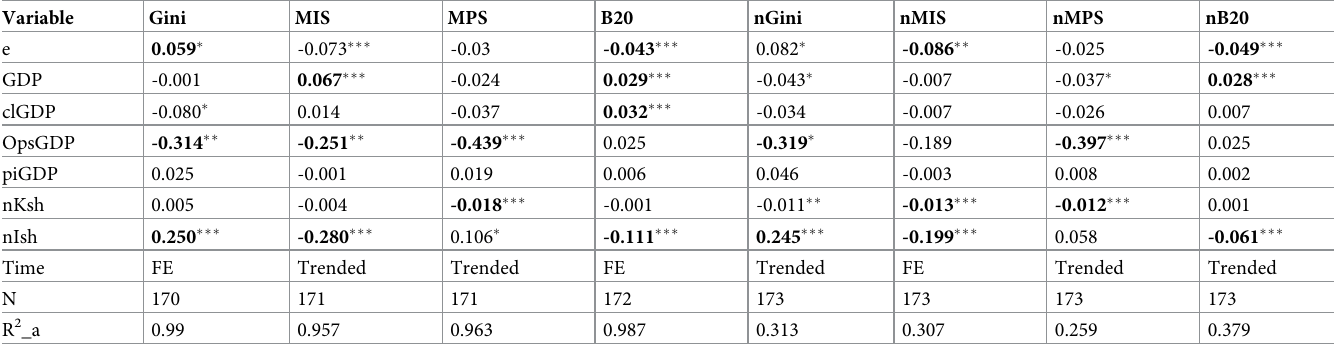
Table 16. Regression of income distribution measures on GDP and capital terms by LSDV and POLS. Variable Gini